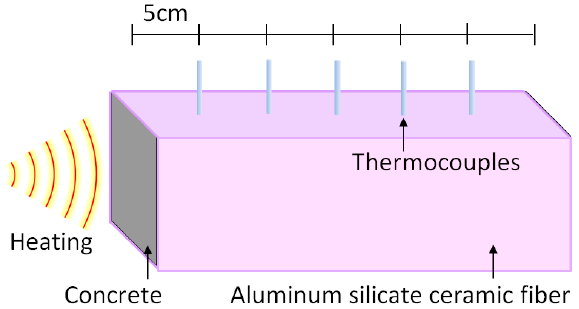
Figure 2. Heat treatment of concrete specimens.